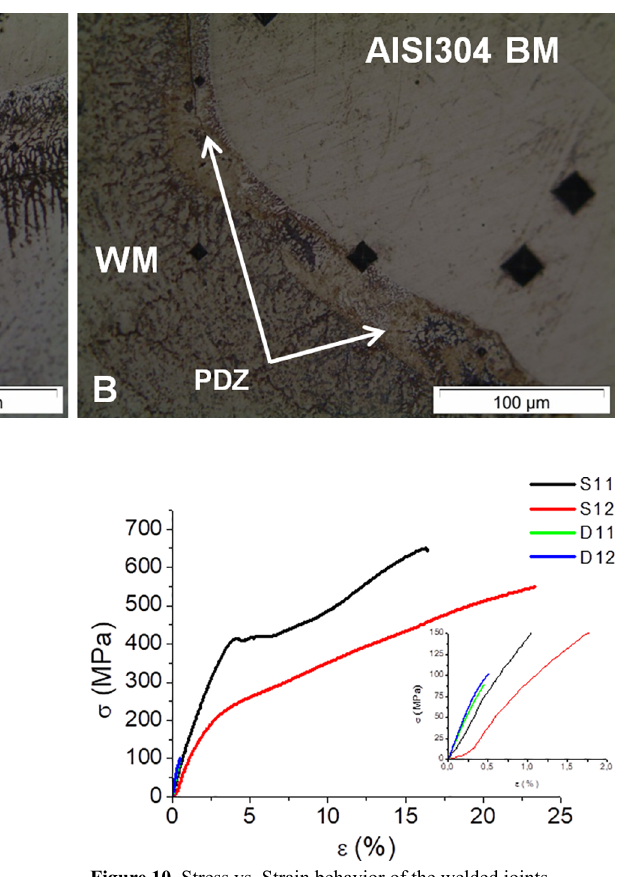
Figure 10. Stress vs. Strain behavior of the welded